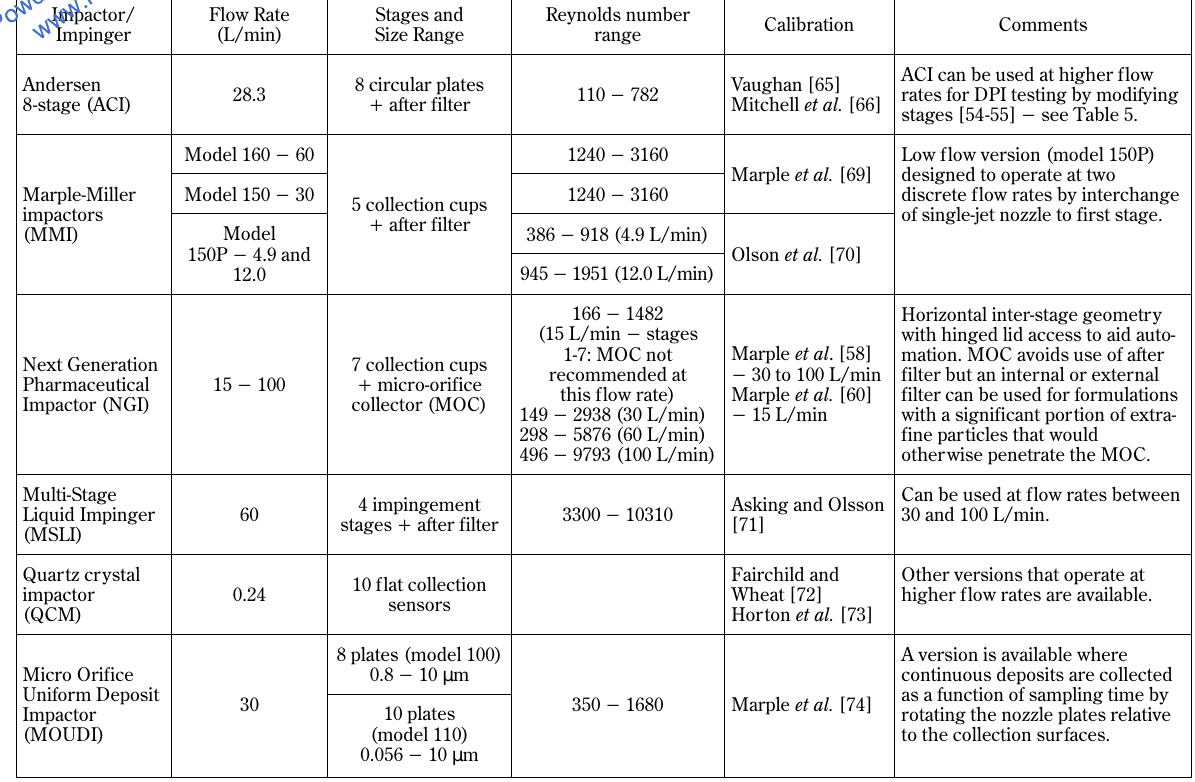
Table 4 Characteristics of cascade impactors used to size-analyze medical aerosols from inhalers